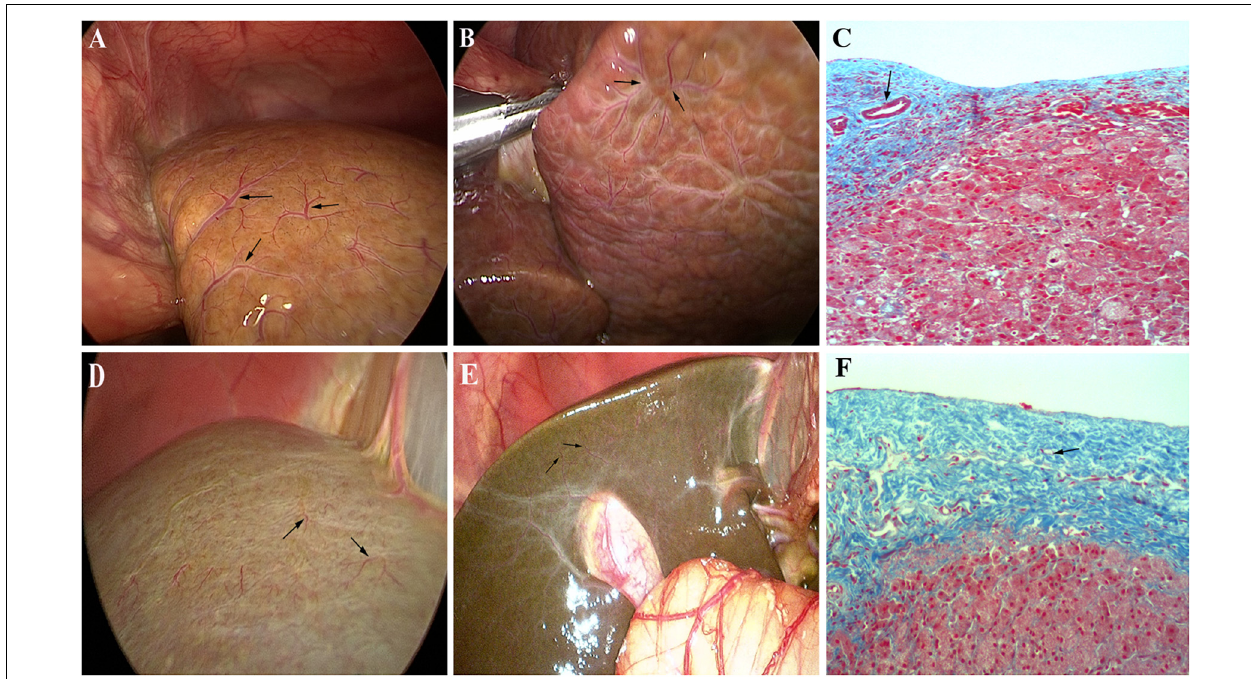
FIGURE 2 | Type of HSST sign: typical HSST sign: (A) concentrated type (arrow) of the HSST sign in a 58-day-old male with BA; (B) dispersed type (arrow) of the HSST sign in a 61-day-old male with BA; (C) dilated arteries (arrow) in the hepatic subcapsular area in BA (Masson; × 100). Atypical HSST sign: Tiny vessel plexuses in a 55-day-old male with AGS (D) and in a 51-day-old male with NHS (E) . (F) Vessels in AGS were revealed as dilated capillaries (arrow) in the hepatic subcapsular region (Masson; × 100).